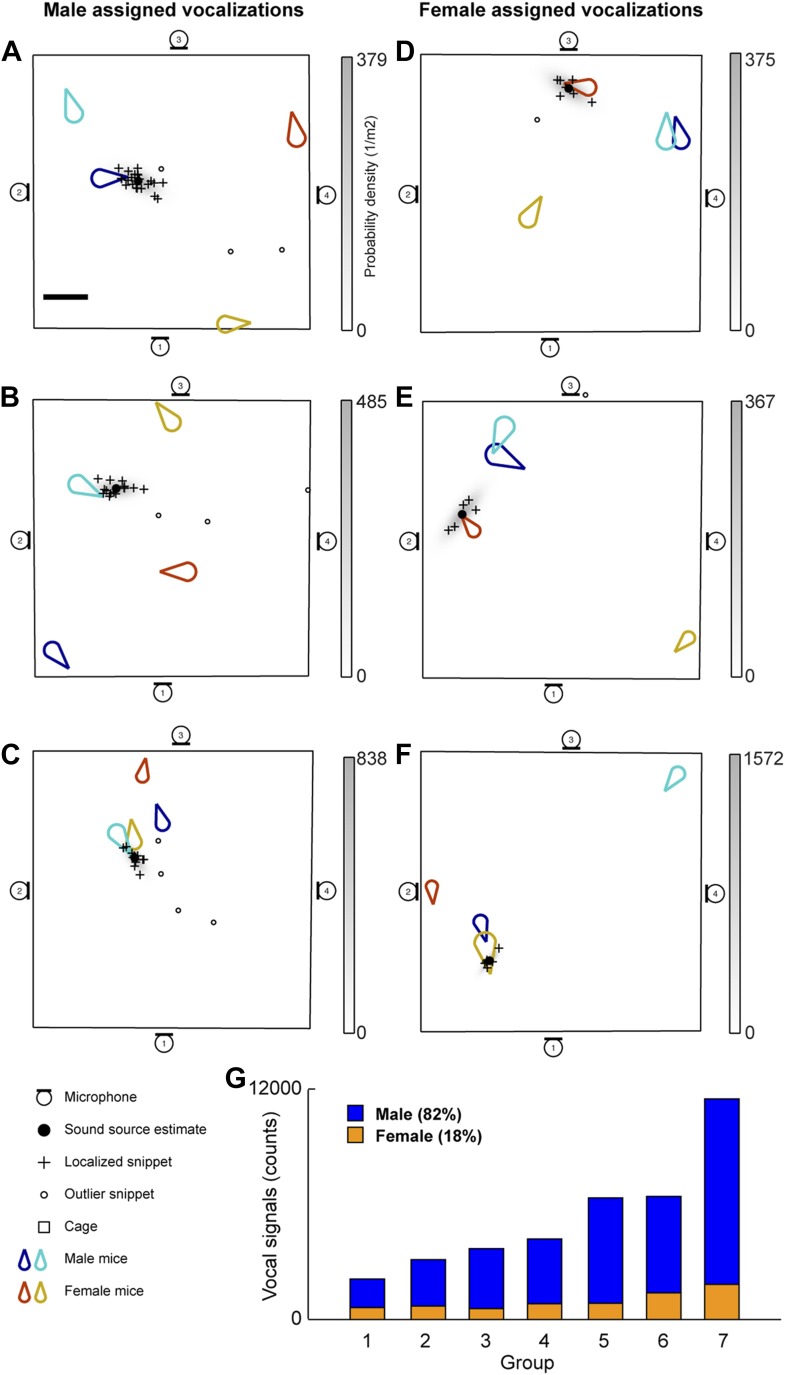
Microphone array reveals both male and female mice vocalize during social interactions.(A–C) Examples of sound source assigned to a male mice in the presence of multiple mice. (D–F) Examples of sound source assigned to female mice when groups of mice are present. (G) Male (blue) and female (orange) vocal signal counts during each recording session (groups displayed in ascending order of total call number).